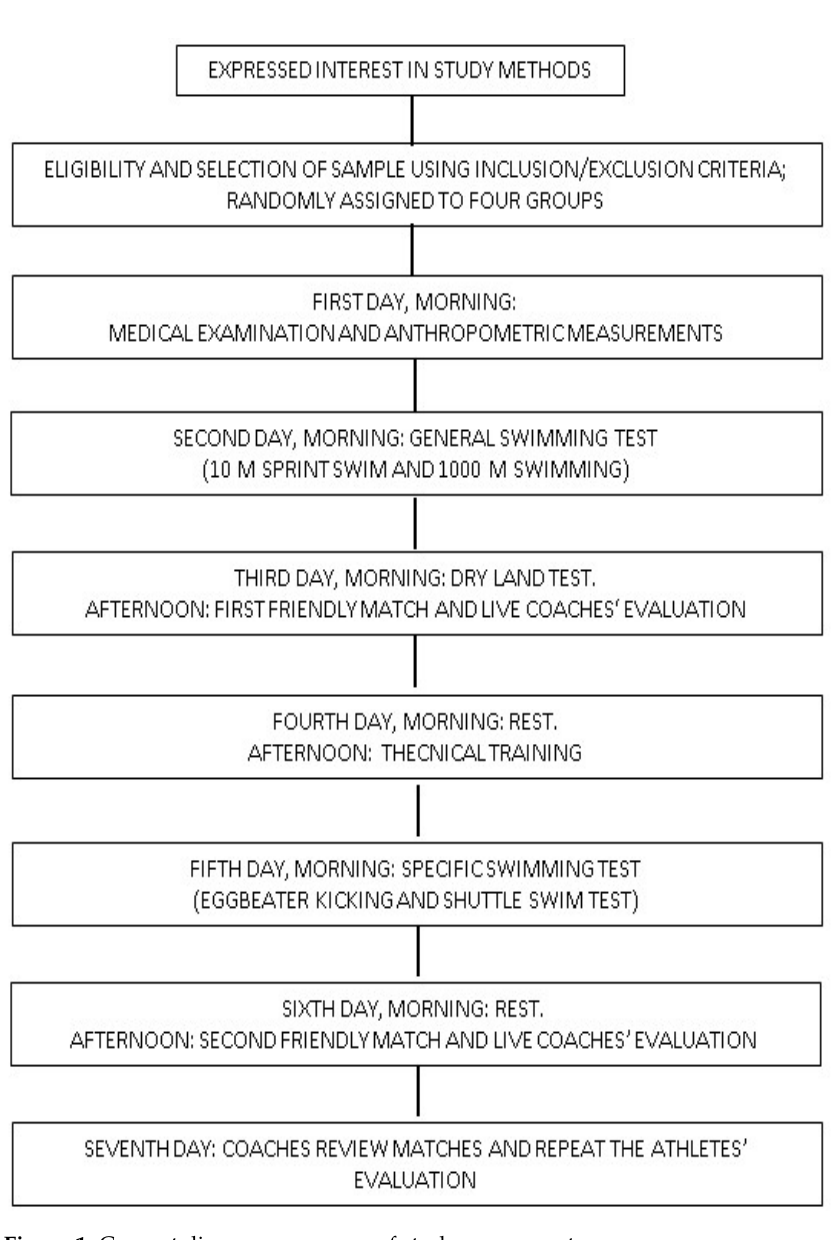
Figure 1. Consort diagram: sequence of study assessments.